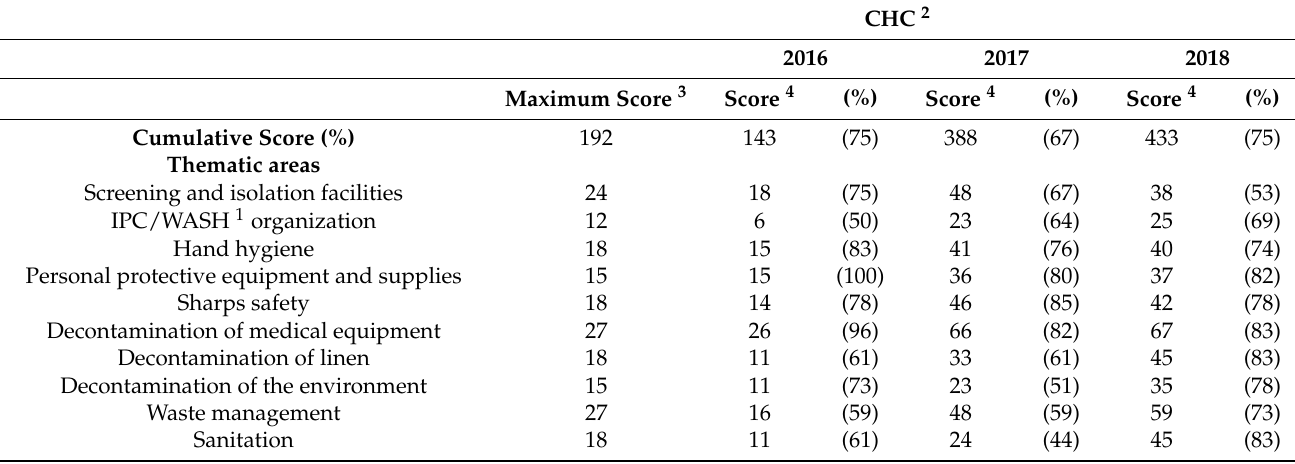
Table 2. Average yearly compliance in relation to scores on a National IPC/WASH 1 assessment tool in Community Health Centers, Kenema district, Sierra Leone (2016–2018).